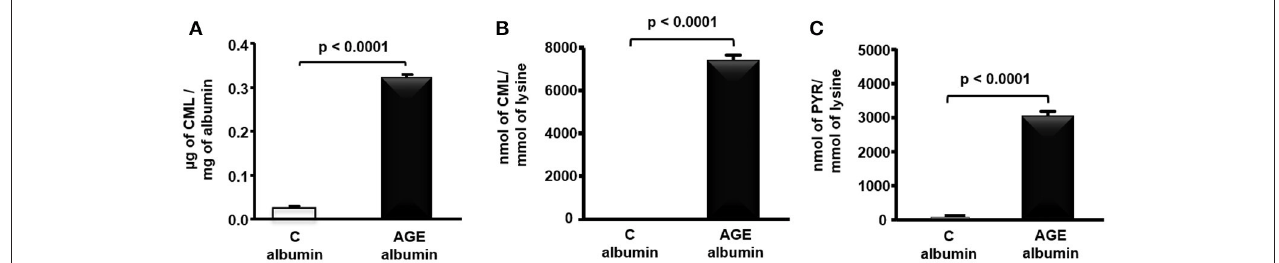
FIGURE 1 | Carboxymethyllysine (CML) and pyrraline (PYR) in control (C) and advanced glycated (AGE) rat albumin. Rat fatty acid free albumin (RSA) was incubated with 10 mM glycolaldehyde (AGE-albumin) or PBS only (C albumin) for 4 days, at 37 ◦ C, under sterile conditions. CML content was quantified in albumin by ELISA (A) and LC-MS/MS (B) , and PYR (C) , by LC-MS/MS. Results were compared by the unpaired Student’s t -test ( n = 3).